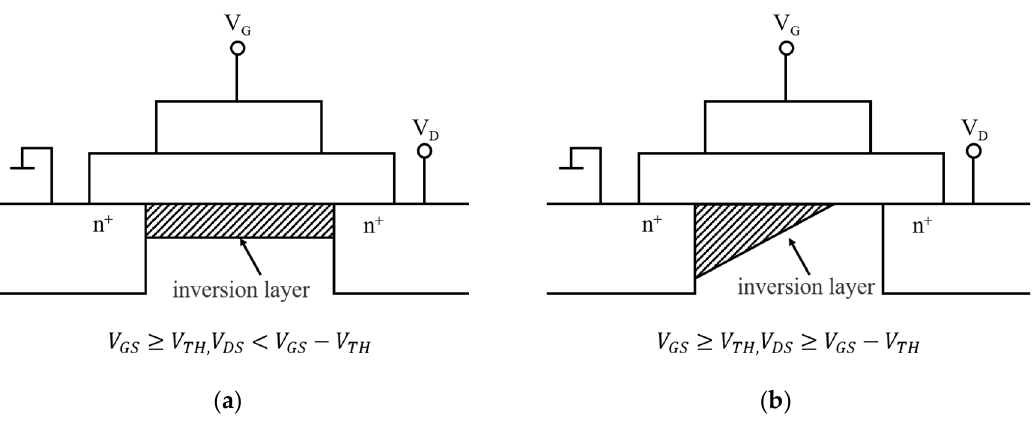
Figure 5. Operating interval characteristics of TFTs: ( a ) linear region; ( b ) saturated region.